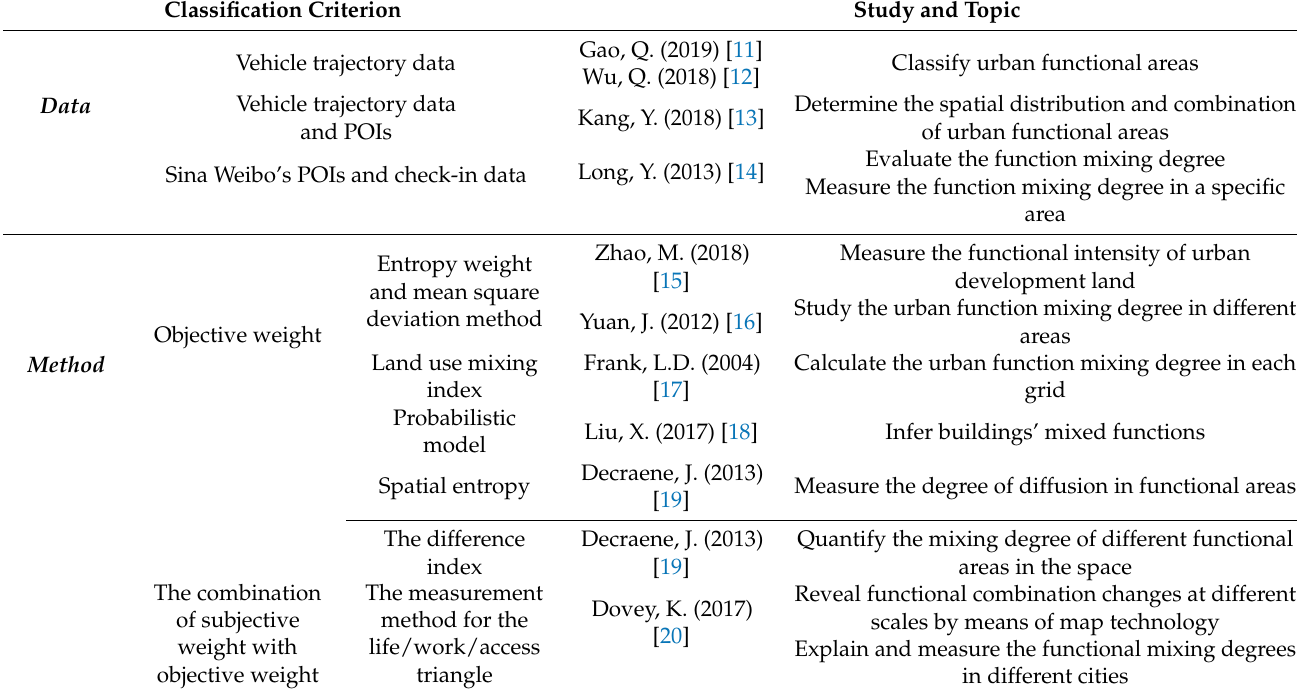
Table 1. Comparison of synchronous research on urban function mixing egree. Classification